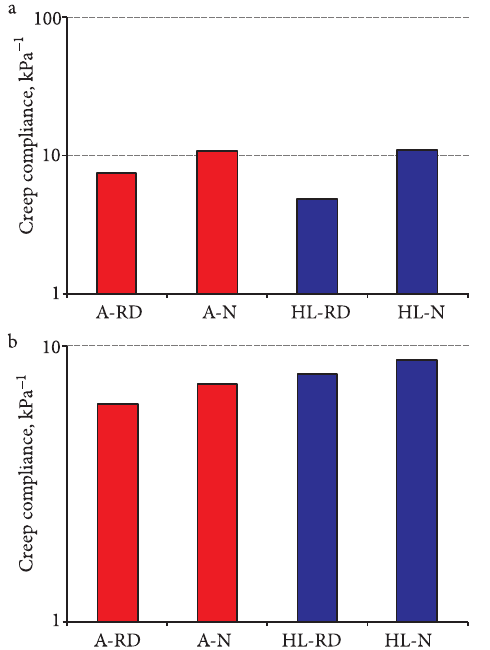
Fig. 9. Test results of elastic recovery according to